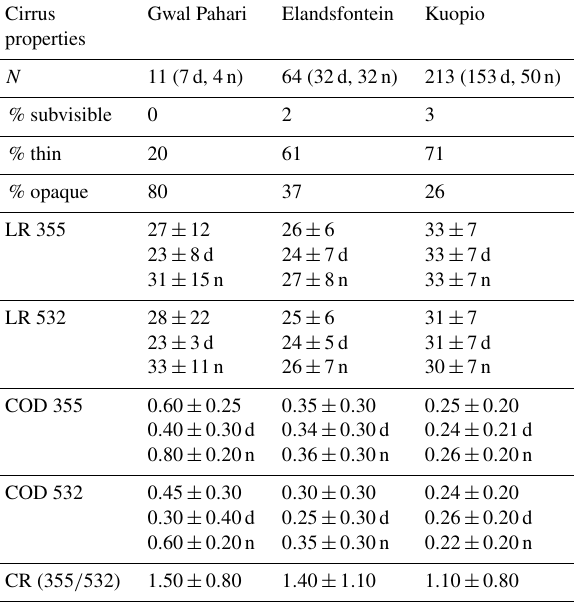
Table 3. Average cirrus optical properties for the three regions for daytime and nighttime measurements (days – d; nights –